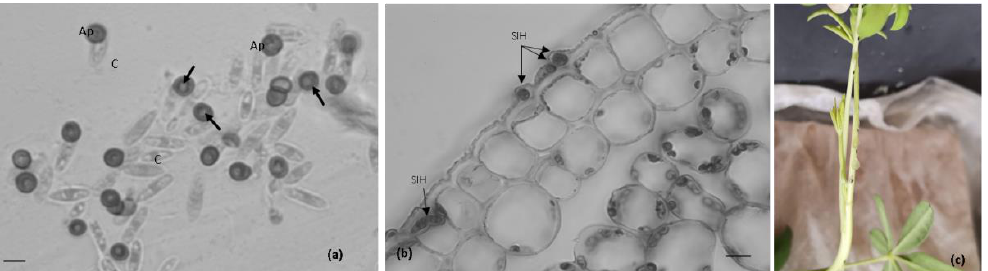
Figure 1. The Colletotrichum lupini infection process on petioles of Lupinus mutabilis and the corre- sponding macroscopic symptoms. ( a , b ). Light microscopic observations, cotton blue lactophenol staining. ( a ). Conidia (C) germination and appressoria (Ap) formation, 1 day after inoculation (dai). Note the appressoria light spots (arrows) on melanized appressoria. ( b ). Subcuticular intramural hyphae (SIH) developing between the cuticle and epidermal cell walls 2 dai. ( c ). Petioles without disease symptoms 2 dai. Scale bar = 10 µm.